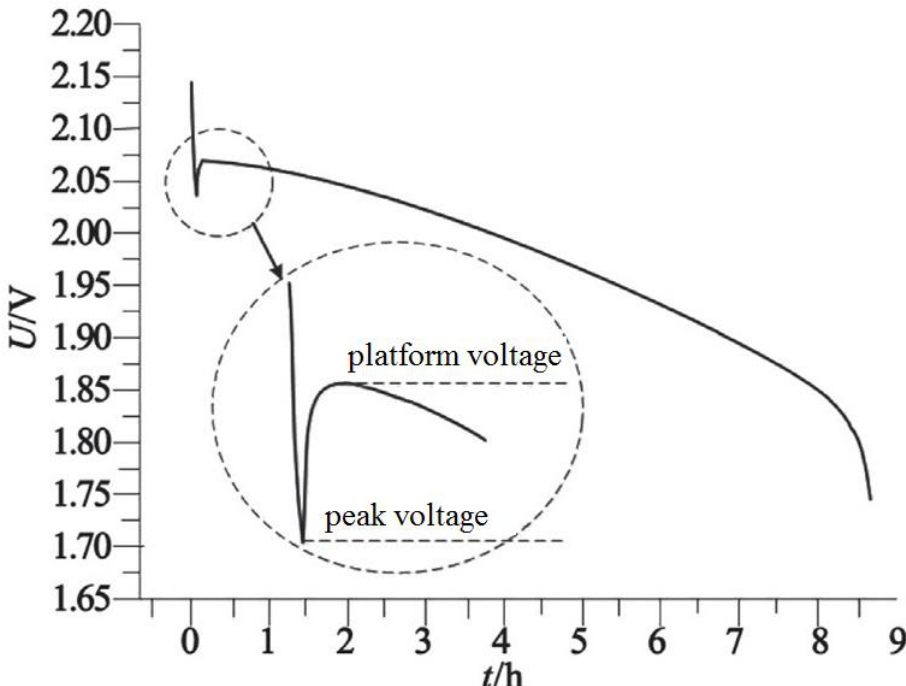
Figure 3. Coup de fouet of a lead-acid battery.